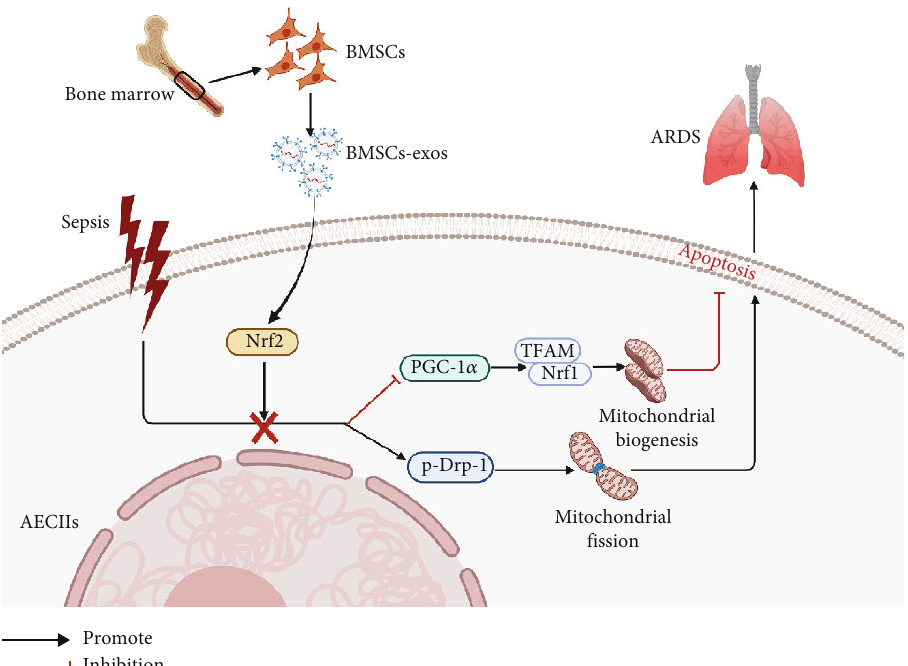
Figure 6: Proposed mechanism for the function of BMSC-exos in alleviating sepsis-associated acute respiratory distress syndrome by activating the Nrf2 pathway to reverse mitochondrial dysfunction. Mitochondrial dysfunction, including depression of mitochondrial biogenesis and excessive mitochondrial fi ssion, might contribute to sepsis-induced AECII apoptosis. BMSC-exos enhanced the expression of Nrf2, subsequently promoting mitochondrial biogenesis and inhibiting mitochondrial fi ssion in AECIIs, alleviating AECII apoptosis and ARDS. Arrows indicate positive regulation, T-bars indicate negative regulation, and cross shows the blocking e ff